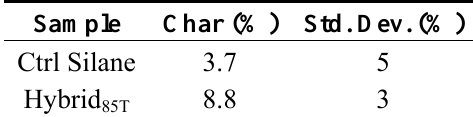
Table 2. Solid residue calculated from thermogravimetric analysis (TGA) analysis performed on uncured Ctrl Silane and Hybrid 85T